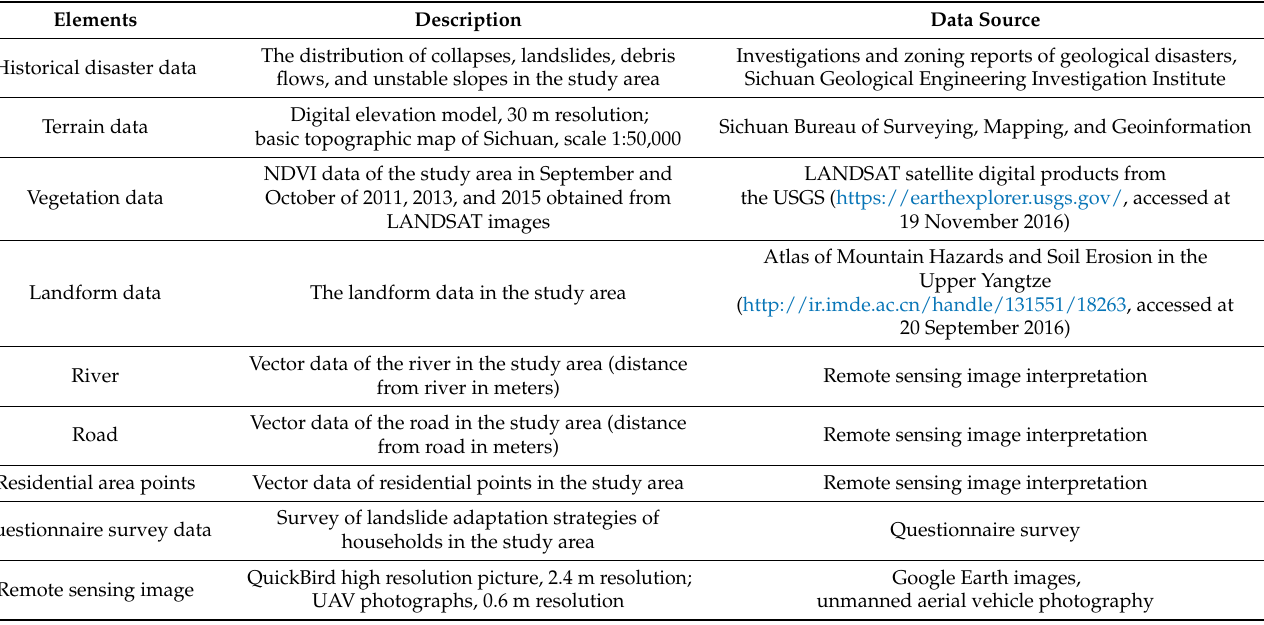
Table 3. Data used in the prediction